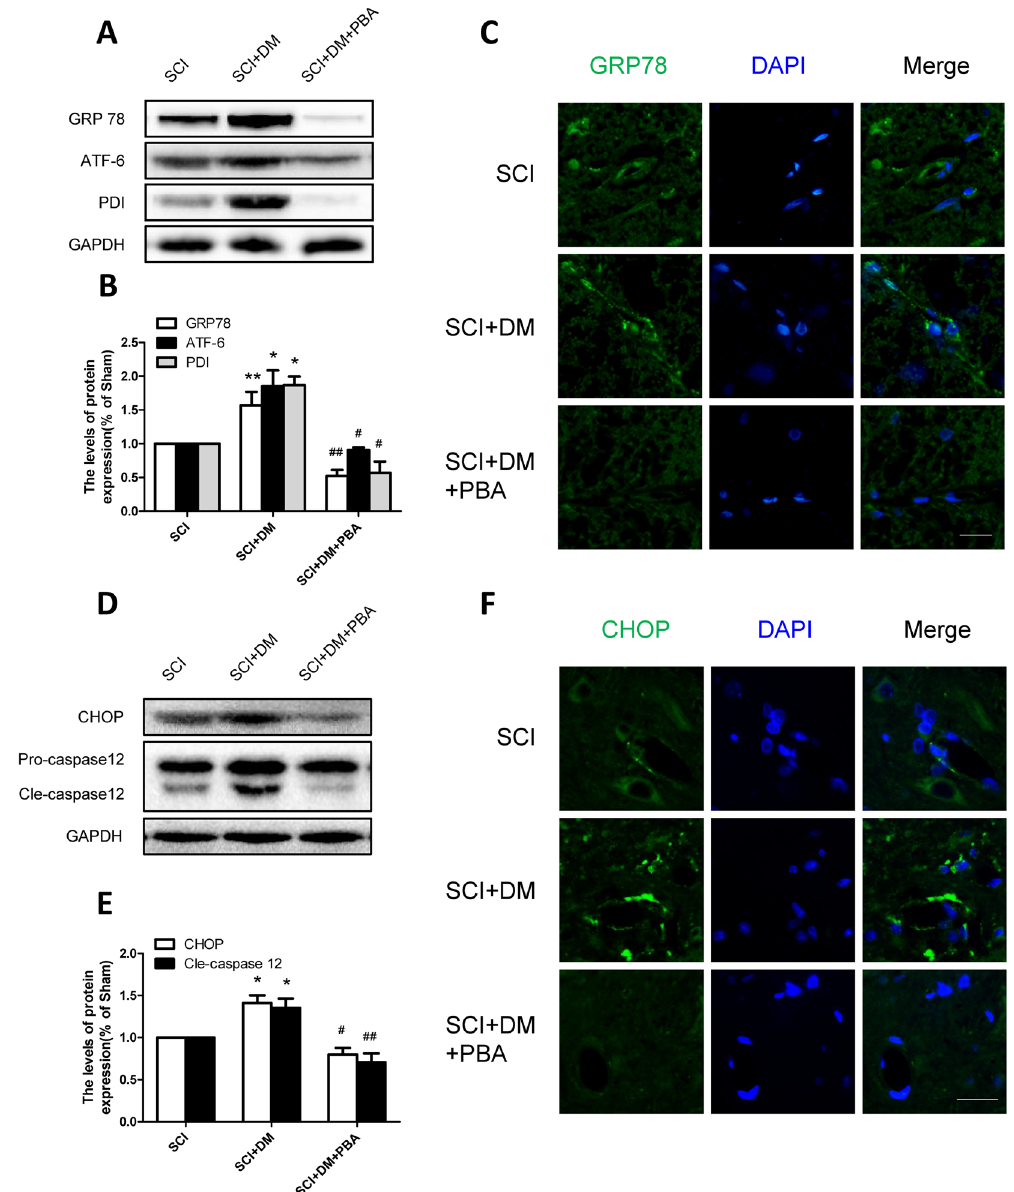
Figure 5. 4-PBA preventes the excessive activation of ER stress in diabetic rats after SCI. ( A , B ) Western blot and quantification of GRP78, ATF-6 and PDI in each group, n = 6. ( C ) Immunofluorescence staining of GRP78 in each group, n = 4. Scale bar = 10 μ m. ( D , E ) Western blot and quantification of CHOP and caspase12 in each group, n = 6. ( F ) Immunofluorescence staining of CHOP in each group, n = 4. Scale bar = 10 μ m. * p < 0.05, ** p < 0.01 vs SCI group, # p < 0.05, ## p < 0.01 vs SCI + DM